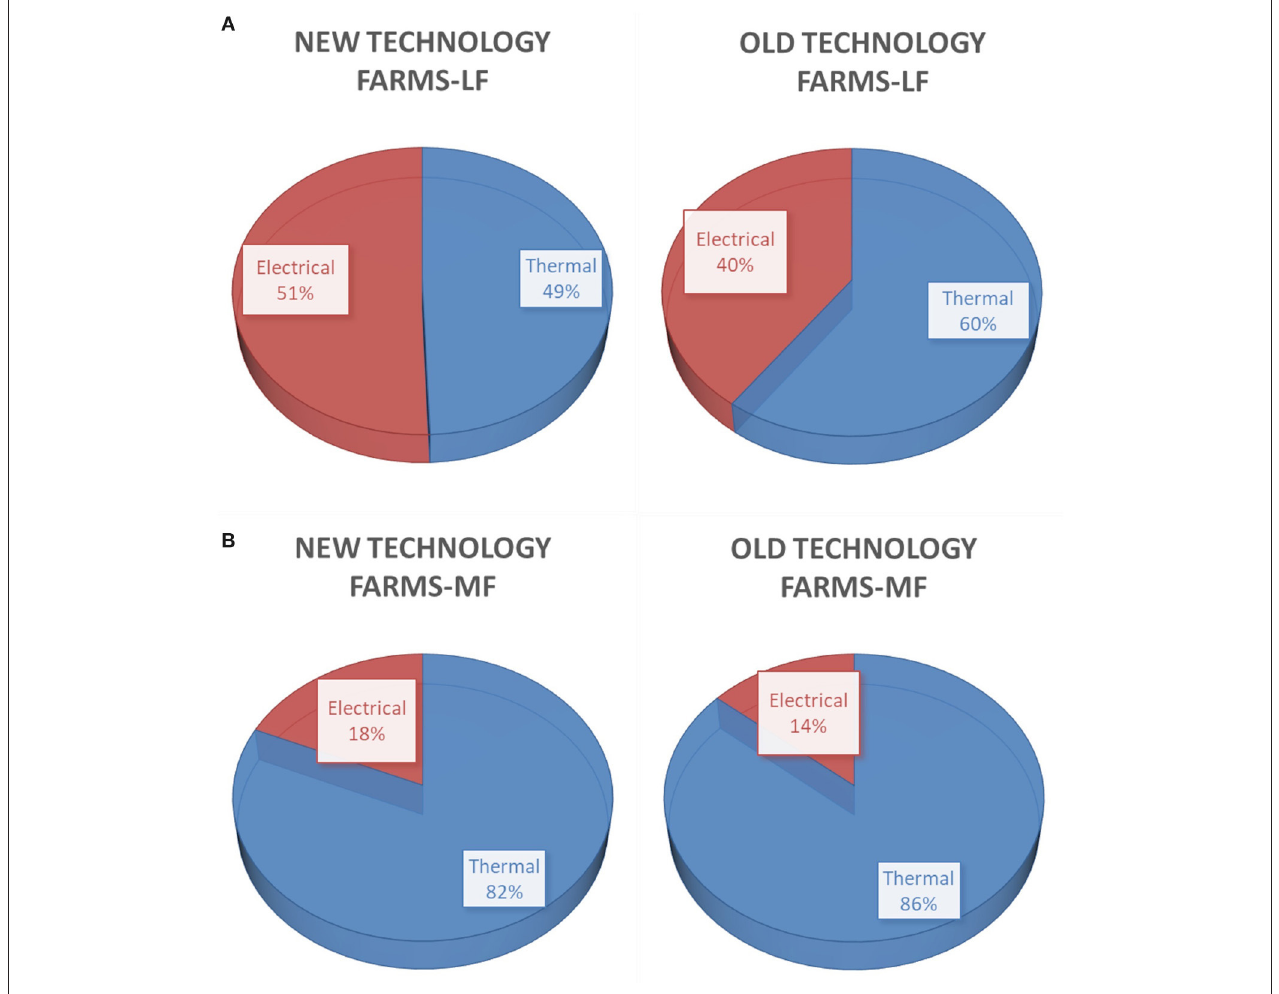
FIGURE 7 | Distribution of total final energy consumption (A) in lowland farms and (B) in mountainous farms, for new and old technology chambers.